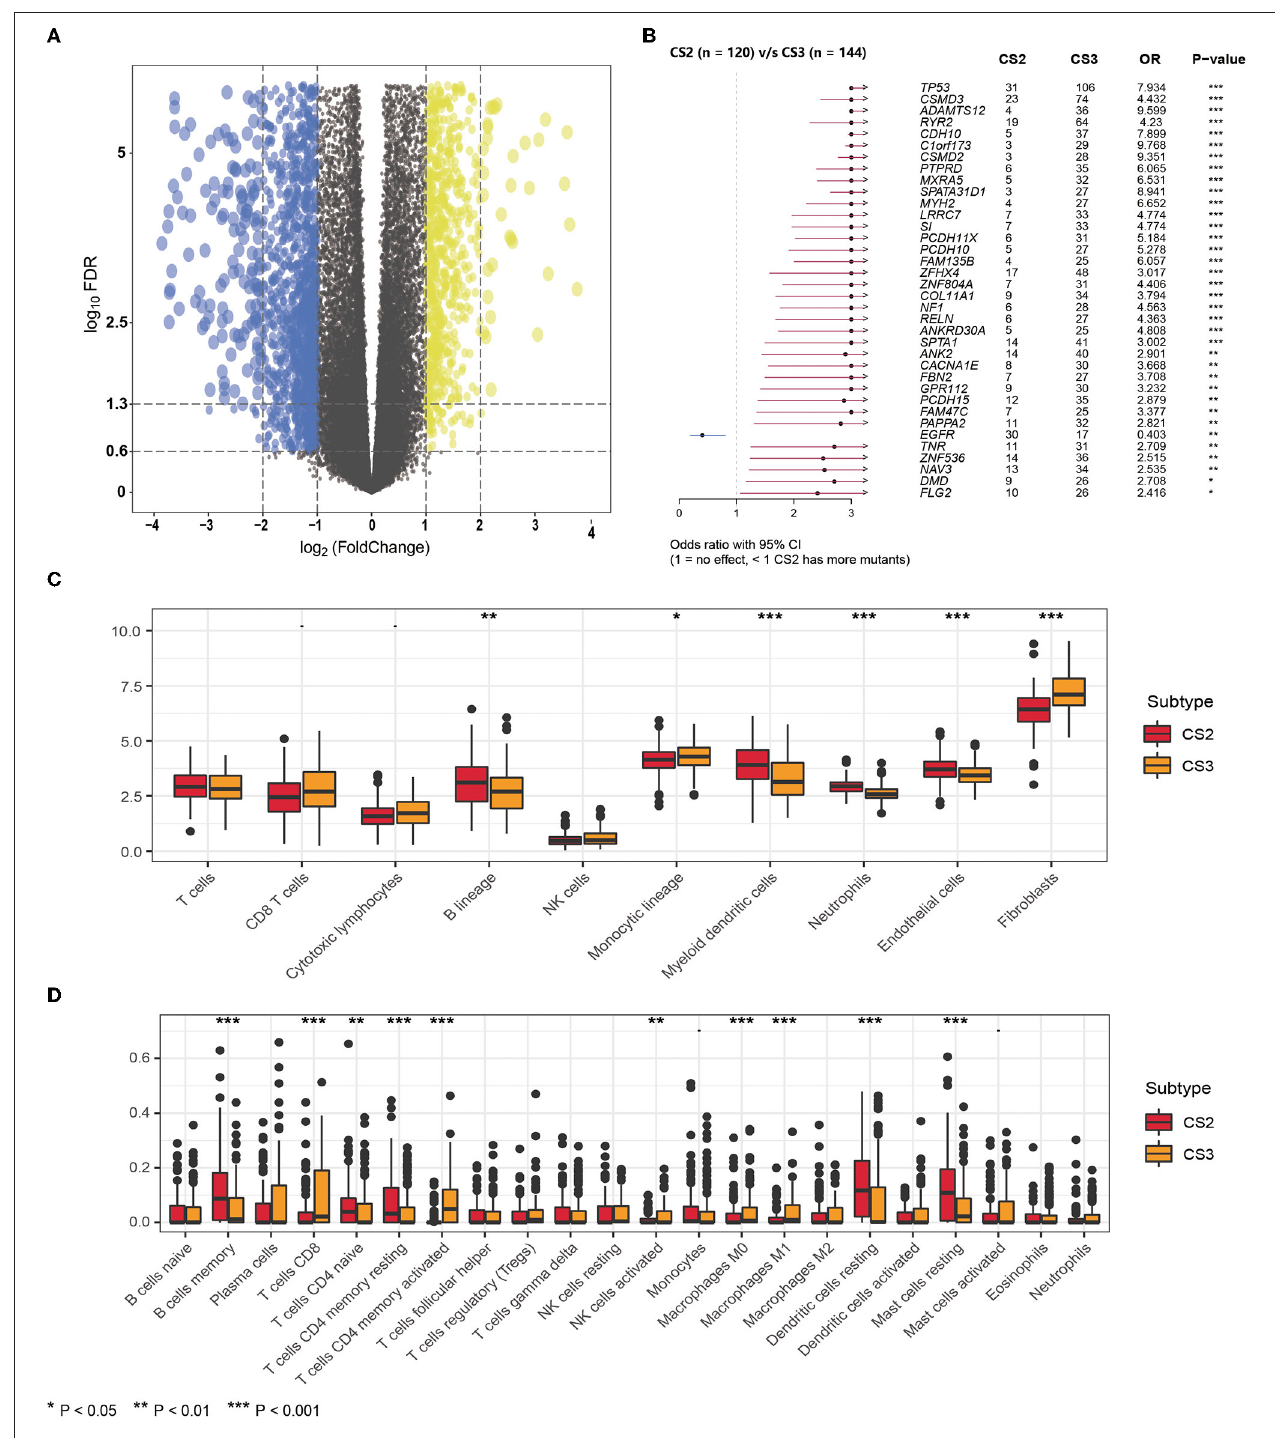
FIGURE 4 | (A) The volcano plot shows the overall pattern of differentially expressed genes in the CS2 and CS3 subgroups. (B) The forest plot displays the significantly differentially mutated genes between two subgroups. (C) The boxplot shows the abundance of ten immune infiltrating cells calculated by the MCP-counter algorithm in different subtypes. (D) The boxplot shows the infiltration of LM22 immune cells evaluated by the CIBERSORT method in two subtypes.